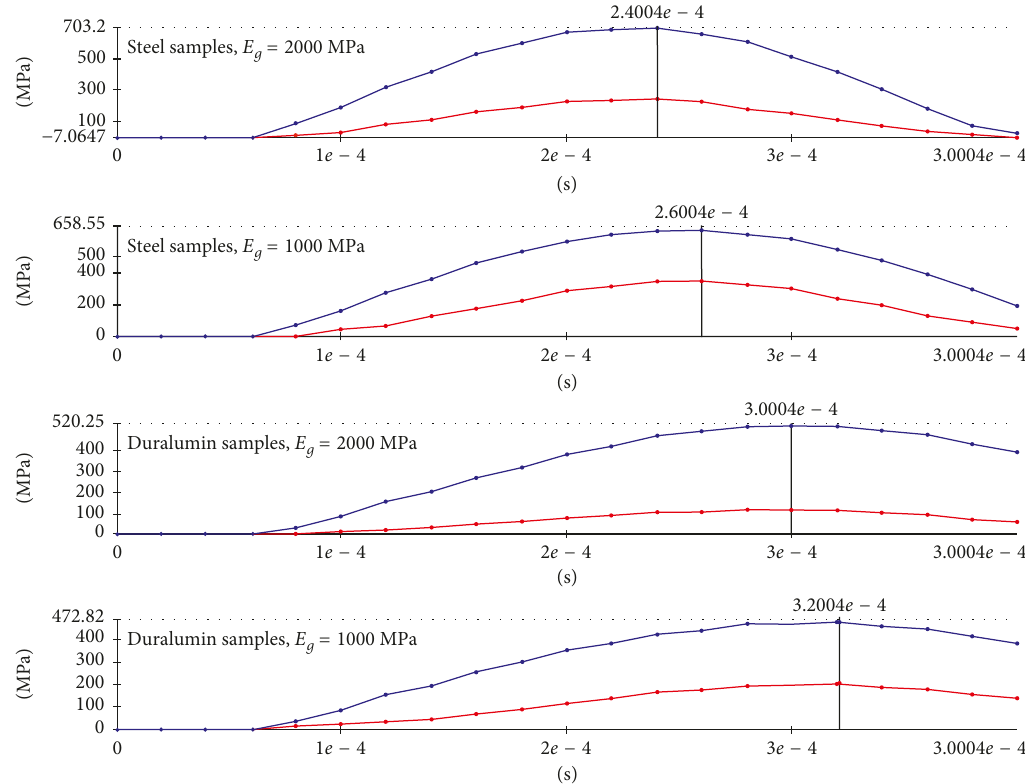
Figure 17: The time history of normal principal stresses in the joints of dynamically impact-loaded block samples in accordance with the material of the samples and Young’s modulus of the adhesive ( E g